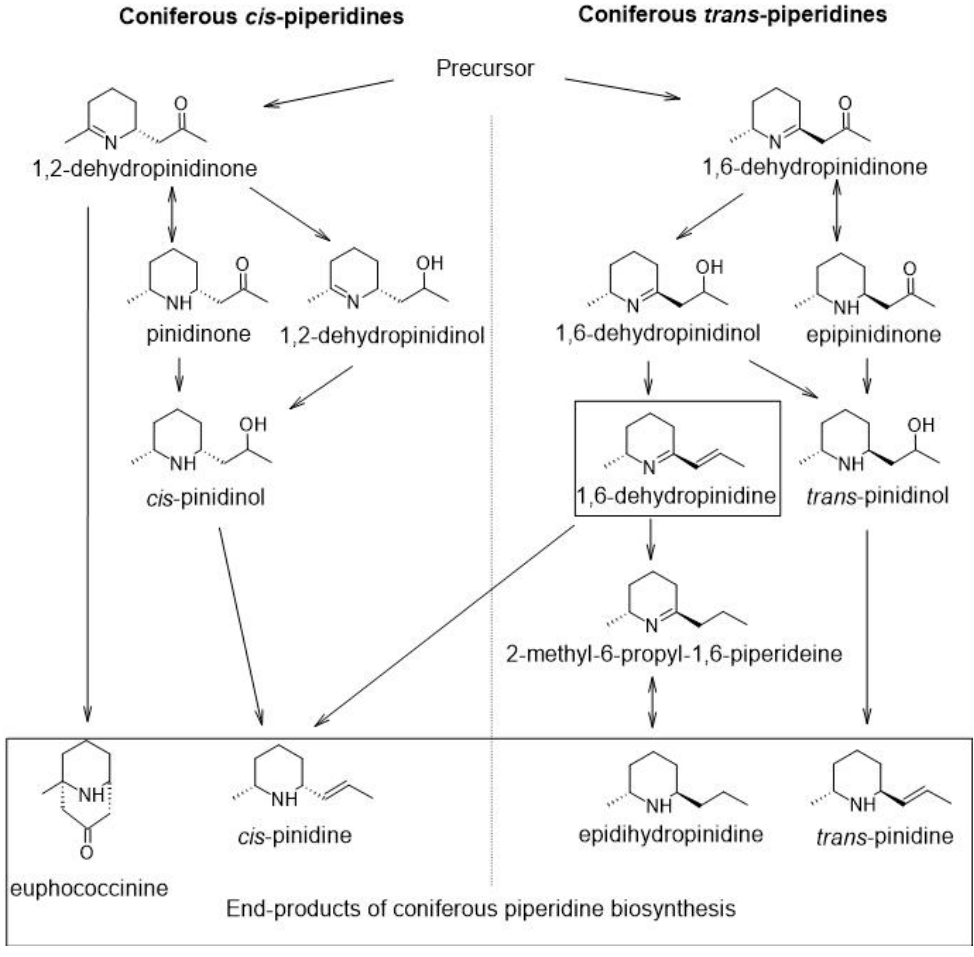
Figure 1. Proposed biosynthesis of coniferous 1,6-desubtituted piperidines according to References